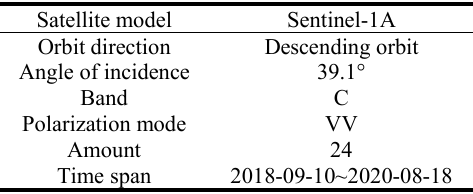
Table 1. Basic parameters of satellite data